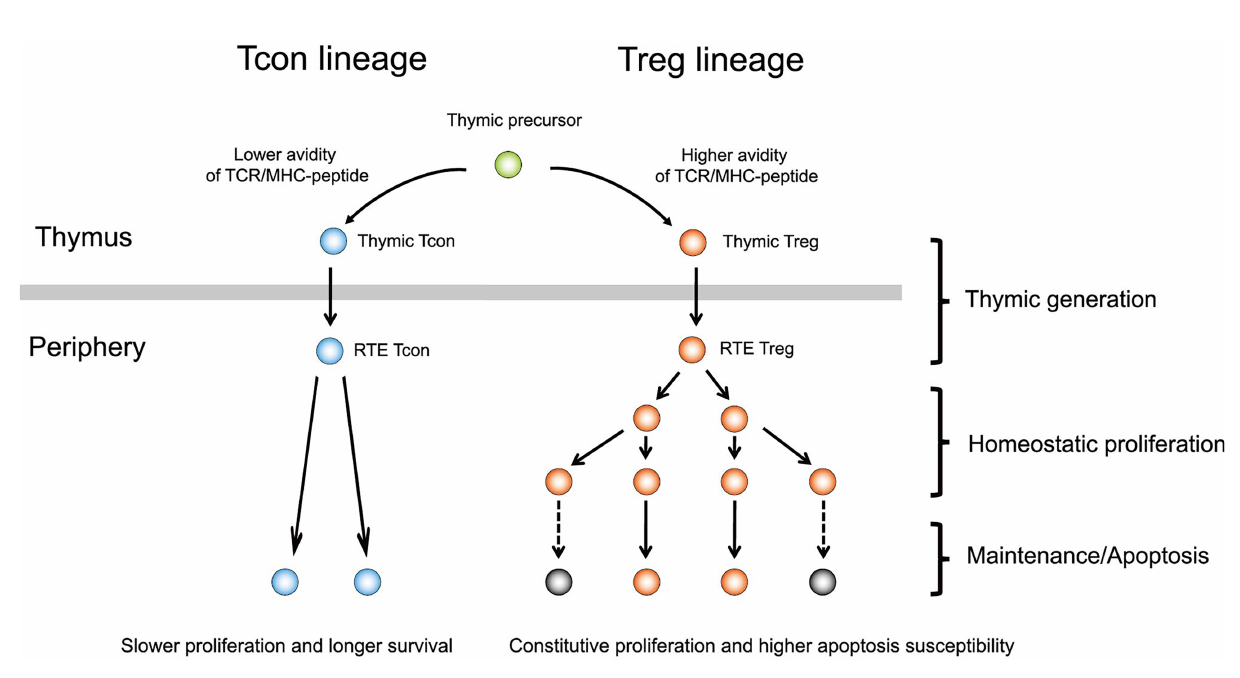
FIGURE 1 | Development and maintenance of regulatory T cells. Tregs are positively selected from a population with a higher avidity of TCR/MHC-peptide in the thymus and emigrate to the periphery. Tregs already exhibit an activated phenotype at emigration to the periphery and undergo rapid homeostatic proliferation. Constitutive proliferation predisposes Tregs to apoptosis. In contrast, Tcons generally undergo slower proliferation and, thus, stable homeostasis with lower apoptosis. Tcon, conventional T cell; Treg, regulatory T cell; RTE, recent thymic emigrant; TCR, T-cell receptor; MHC, major histocompatibility